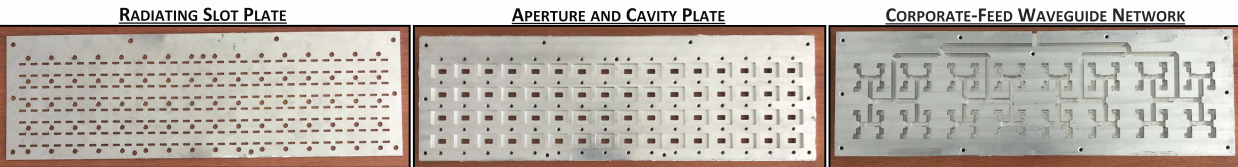
FIGURE 2. Fabricated plates of the WSAA